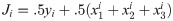
Projection of the phase portrait of the two-layer chunking hierarchical dynamics in the space of three auxiliary variables.This example illustrates the dynamics of a system N
X = 24, N
Y = 3 before (left) and after learning (right) a sequence consisting of 24 patterns of M = 144 pixels. For visualization purposes, the variable space was projected according to Ji=.5yi+.5(x1i+x2i+x3i), where superscript refers to the associated chunk. The plot is colored red when either of the chunks are active (y
i > .9, ∀i). The traces were obtained from 12 runs starting from random initial conditions in the vicinity of the origin of the transformed space. Before learning, the network reaches stable fixed points. After learning, the network results in a closed chunking sequence (black) that consists of several heteroclinic cycles that represent the chunks (red). Each of the three chunks consist of EM, as the system visits the eight states in each chunk. Note however that the projection used here effectively reduces these to 9 (three states per chunk) for visualization purposes.